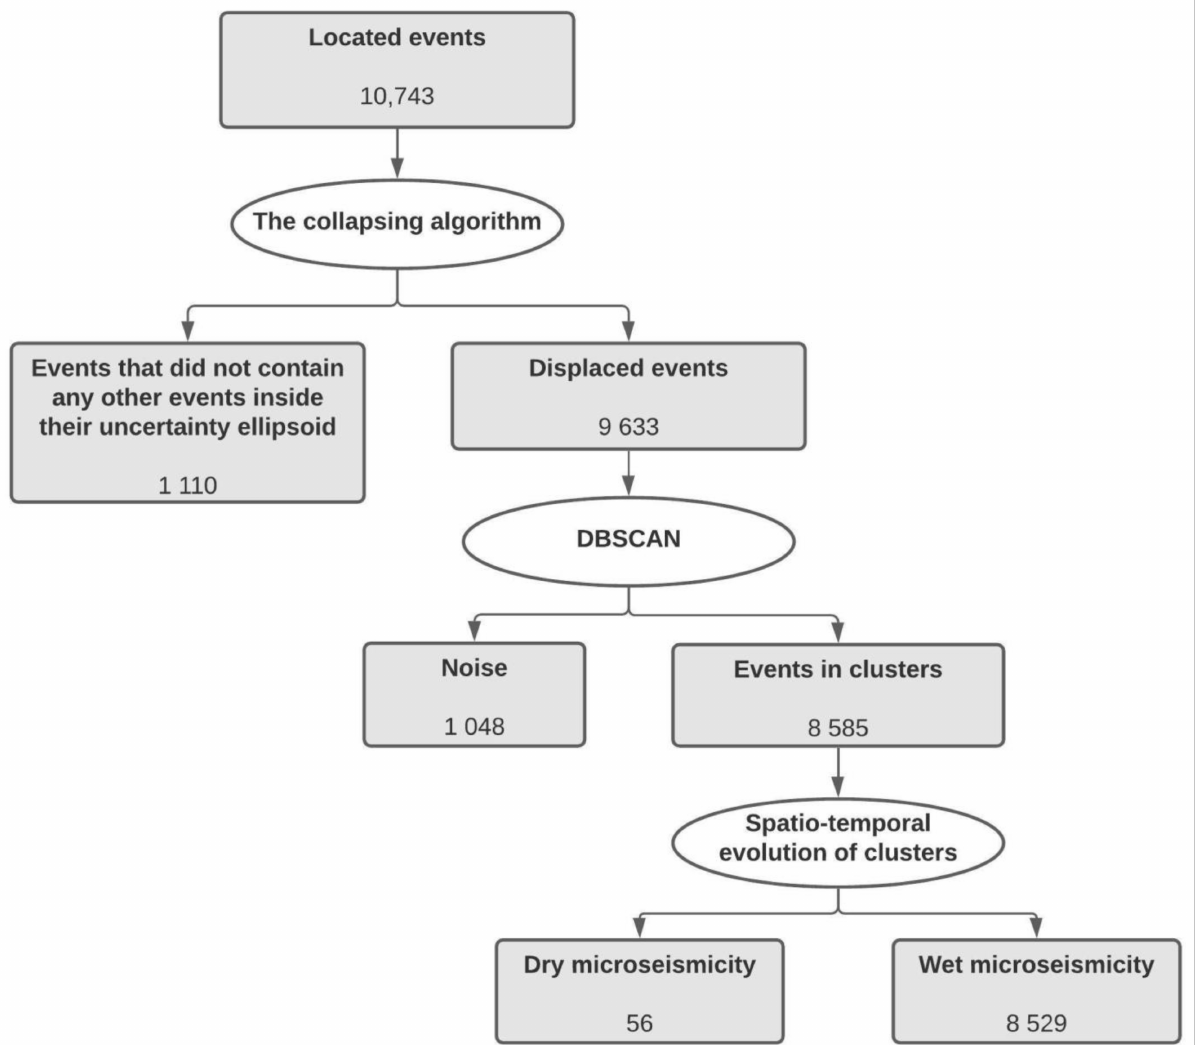
Figure 5. Flowchart describing wet microseismicity